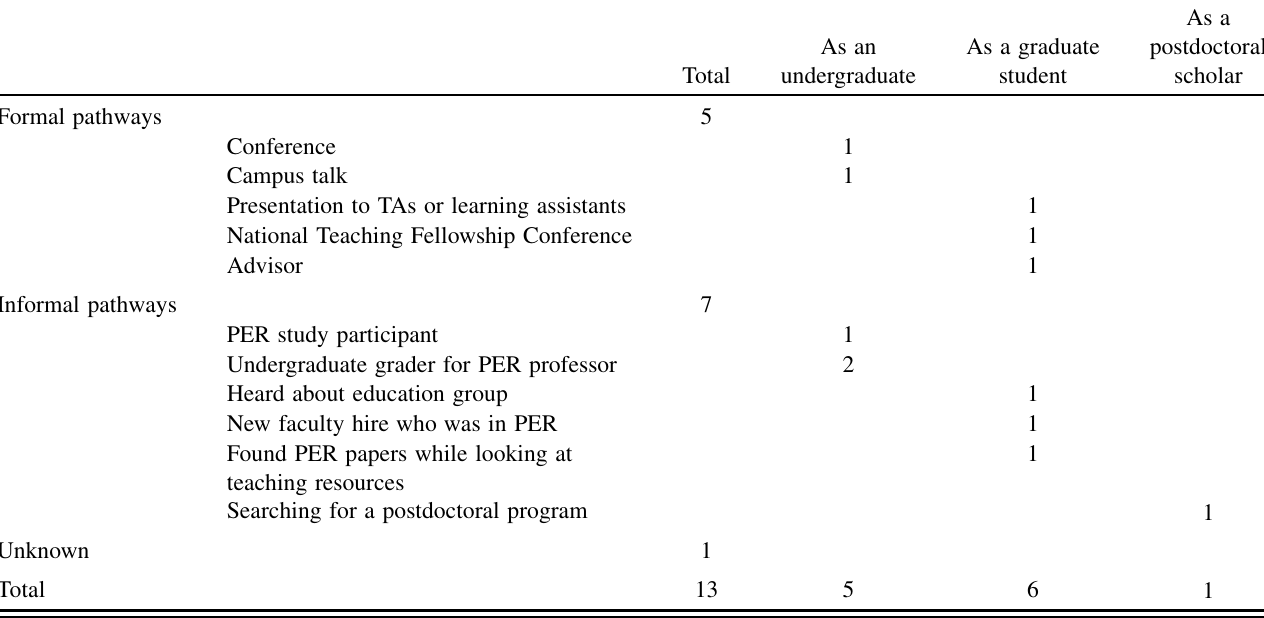
TABLE III. Participant discovery of